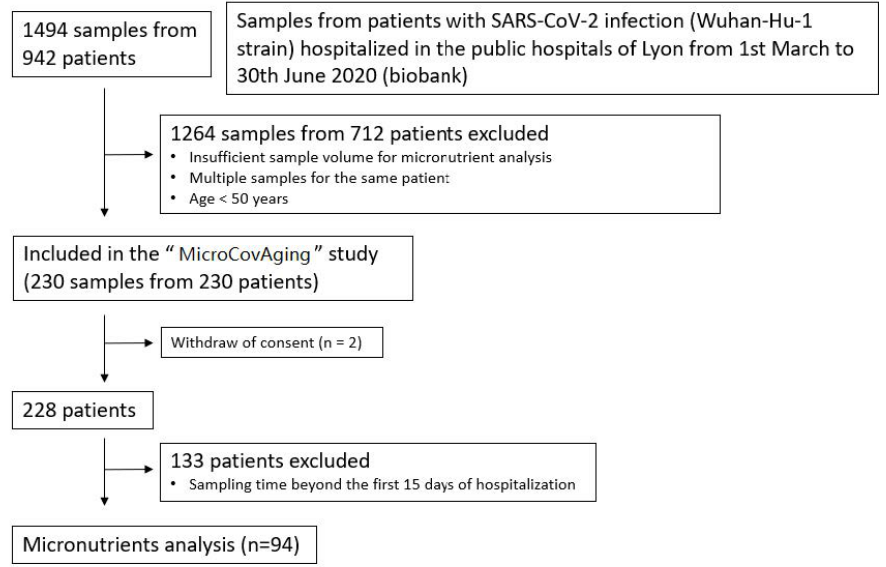
Figure 1. Flow chart of the patients included in the study.